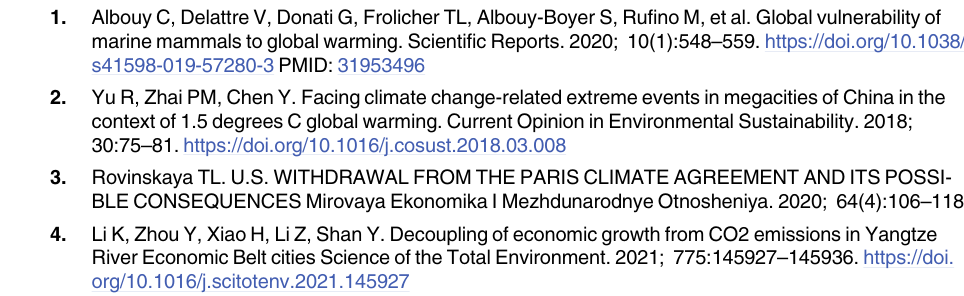
S2 Table. Coupling coordination degree of urban low carbon economy efficiency and digi- tal finance from 2012 to